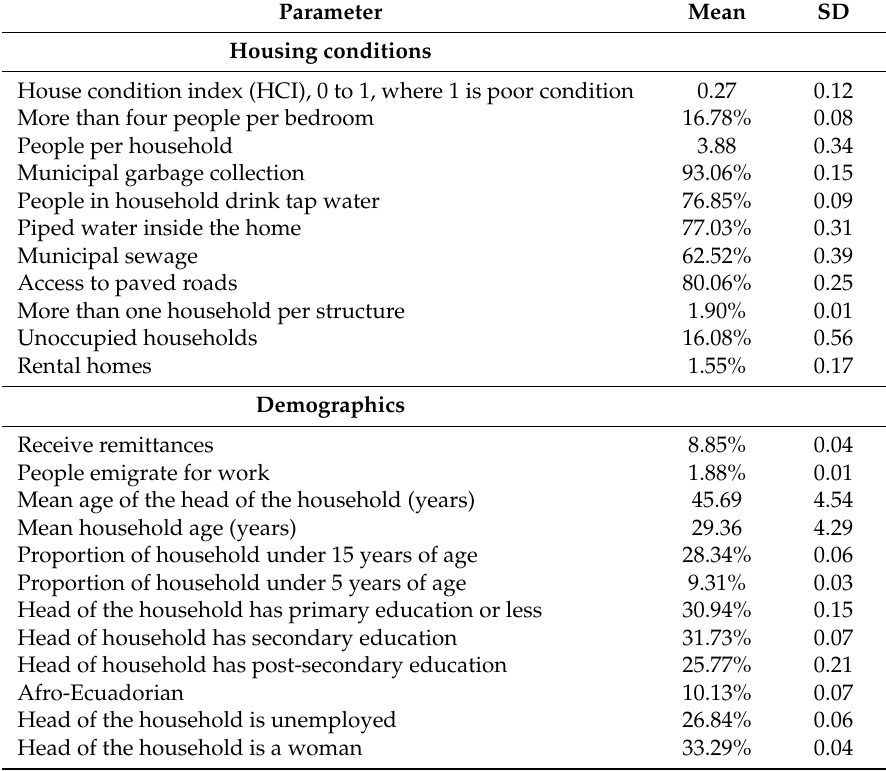
Table 1. Socio-ecological parameters tested in logistic regression and negative binomial model searches to respectively predict presence of dengue and severity of the